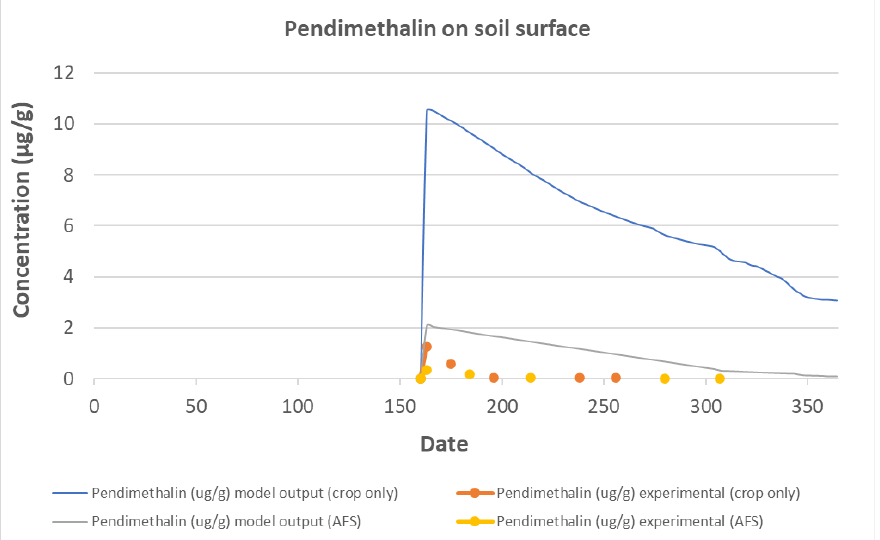
Figure 4. Comparison of pendimethalin concentrations in the top soil layer (0–5 cm) between maize- only and maize-olive systems (Application: Day 163).